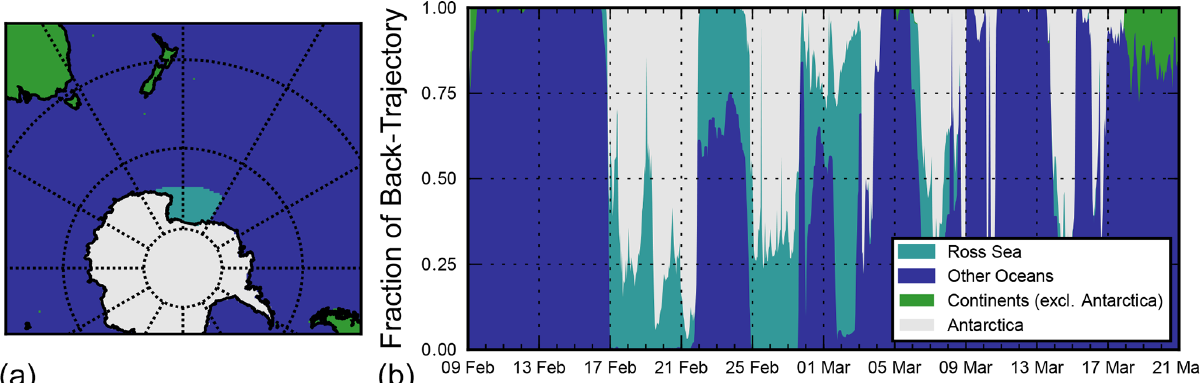
Figure 18. (a) Geographic regions (as indicated by the legend) used for the back-trajectory modelling over the Southern Ocean. (b) The fraction of time air masses spent over different geographic regions in the 5d prior to the measurements. The back-trajectory modelling is described in detail in Hartery et al. (2020b).